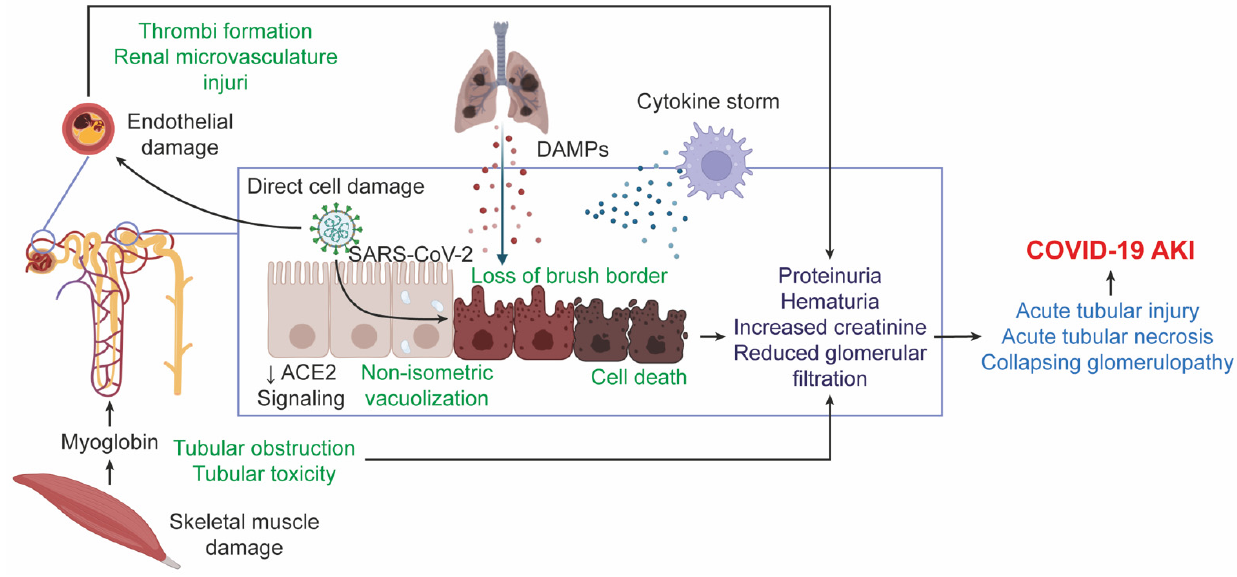
Figure 2. Hypothesis of the COVID-19 AKI pathogenesis. SARS-CoV-2 can cause kidney damage directly or indirectly. Cytokine storm and DAMP secretion from damaged tissues, such as the lung, may contribute to cell death of renal cells such as podocytes and proximal tubular cells. In addition, the prothrombotic state can facilitate the generation of clots in the nephron, which contribute to damage. All this together causes patients who develop COVID-19 AKI to present with proteinuria, hematuria, increased creatinine, and decreased glomerular filtration rate. Acute tubular injury or acute tubular necrosis and collapsing glomerulopathy are generated, which can evolve into COVID-19 AKI.